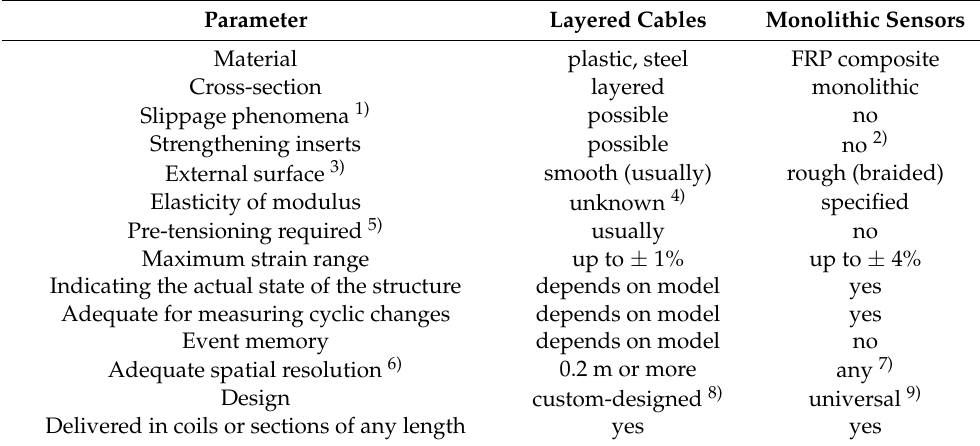
Table 1. Comparison between the general features of layered cables and monolithic sensors (adopted based on